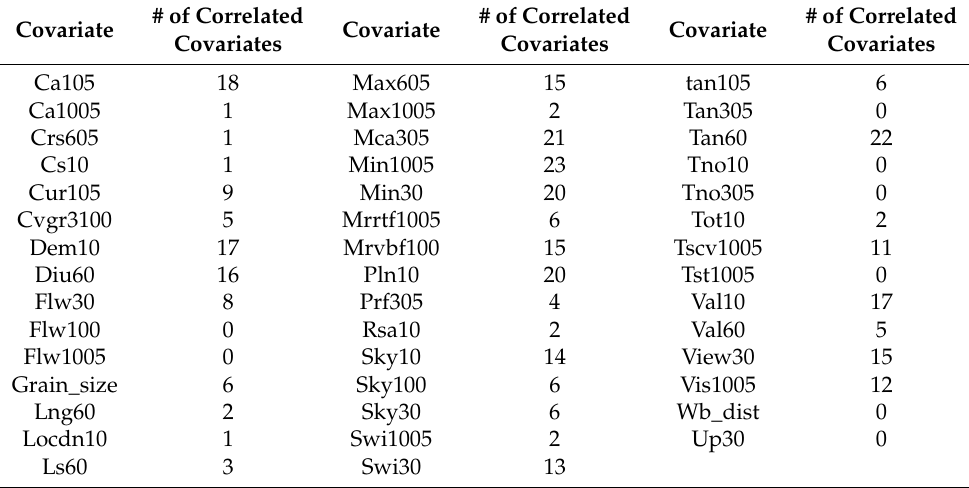
Table 3. The final set of covariates including the number of correlated covariates. Refer to Appendix A for full